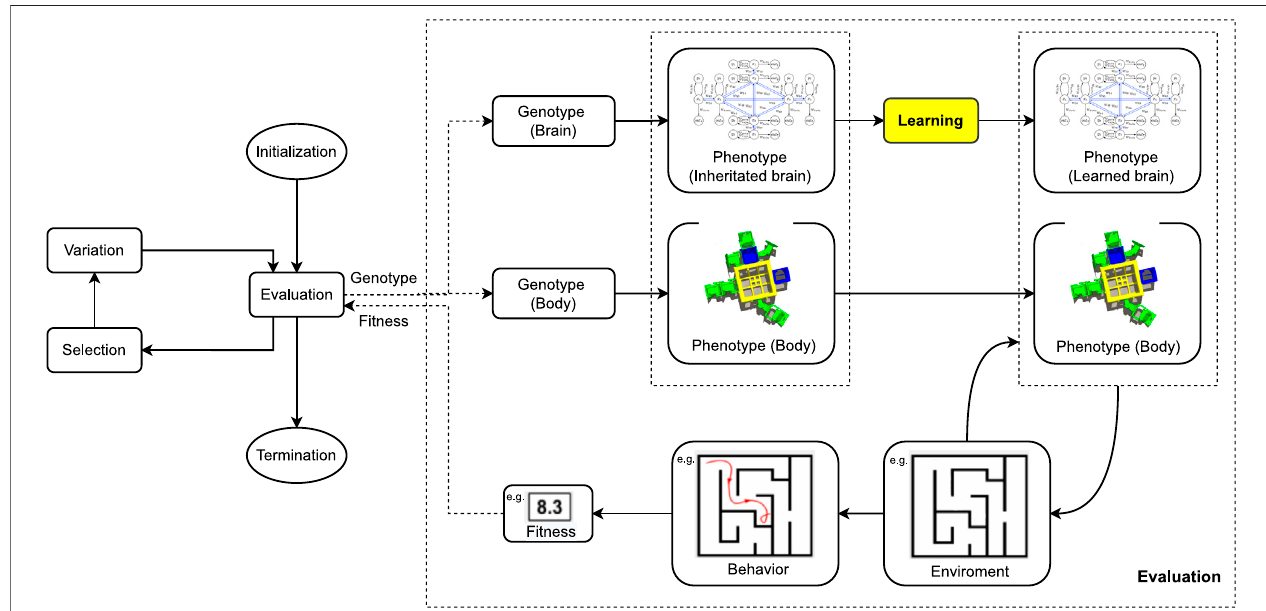
FIGURE 4 | Evolution + Learning Framework. This is a general framework for optimizing robots via two interacting adaptive processes. The evolutionary loop (left) optimizes robot morphologies and controllers simultaneously using genotypes that encode both morphologies and controllers. The learning loop (yellow box inside the Evaluation step of the evolutionary loop) optimizes the controller for a given morphology. Note that in general the fi tness measure used within the evolutionary loop need not be the same as the quality measure used inside the learning method, cf. Algorithm 1.